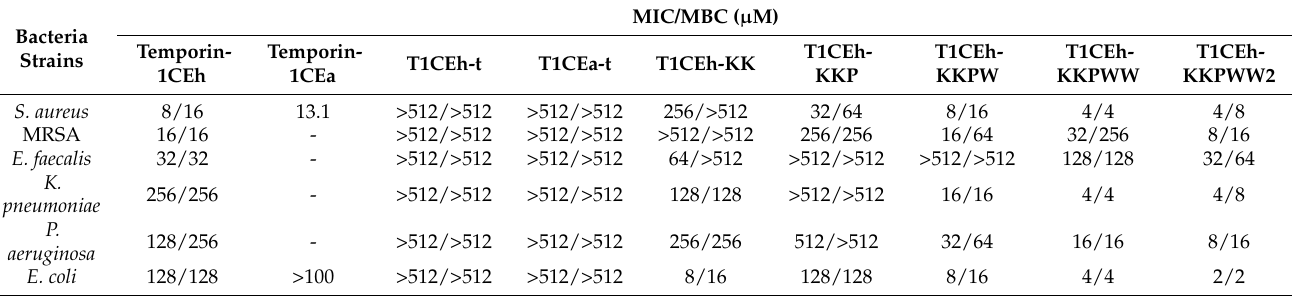
Table 2. The MICs and MBCs of Temporin-1CEh and its analogues as well as Temporin-1CEa against the S. aureus (ATCC CRM 6538), MRSA (NCTC 12493), E. faecalis (NCTC 12697), E. coli (ATCC 8739), P. aeruginosa (ATCC 27853) and K. pneumonia (ATCC 43816), as well as the MICs of Temporin-1CEa against S. aureus and E. coli